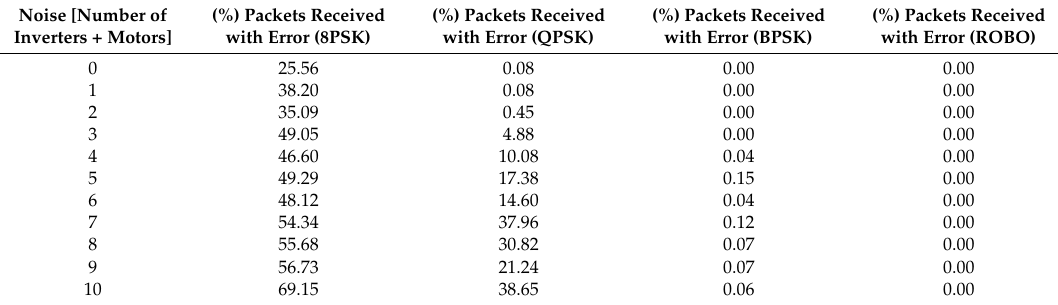
Table 5. Percentage of packets received with errors according to the amount of noise inserted into the network. Noise [Number of Inverters +